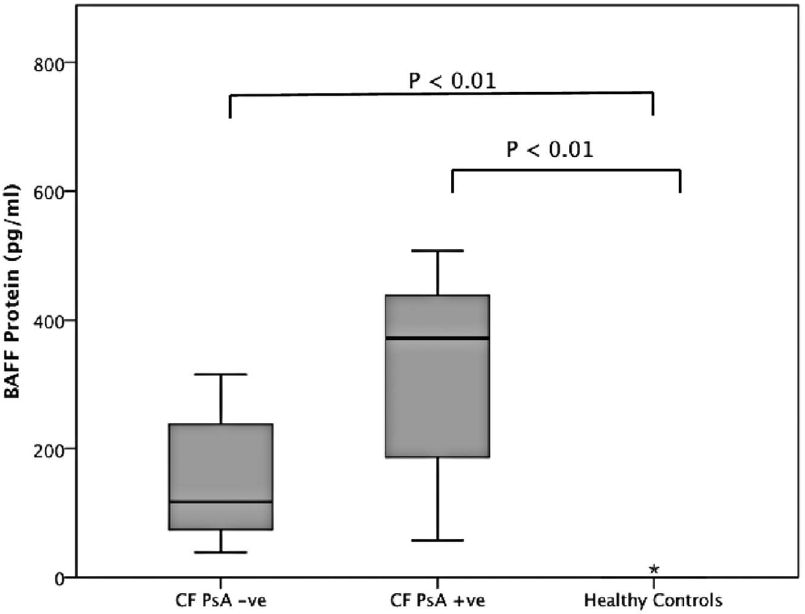
Figure 1. BAFF expression in BAL fluid. Expression was measured by ELISA in BAL fluid from P. aeruginosa positive [n=6] and negative [n=14] CF patients and healthy controls [n=7]. BAFF expression was significantly elevated [p , 0.01] in both the PA infected group and non PA infected